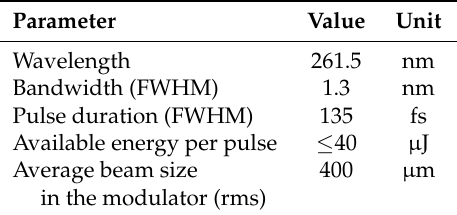
Table 2. Third harmonic generation (THG) seed laser parameters used in the